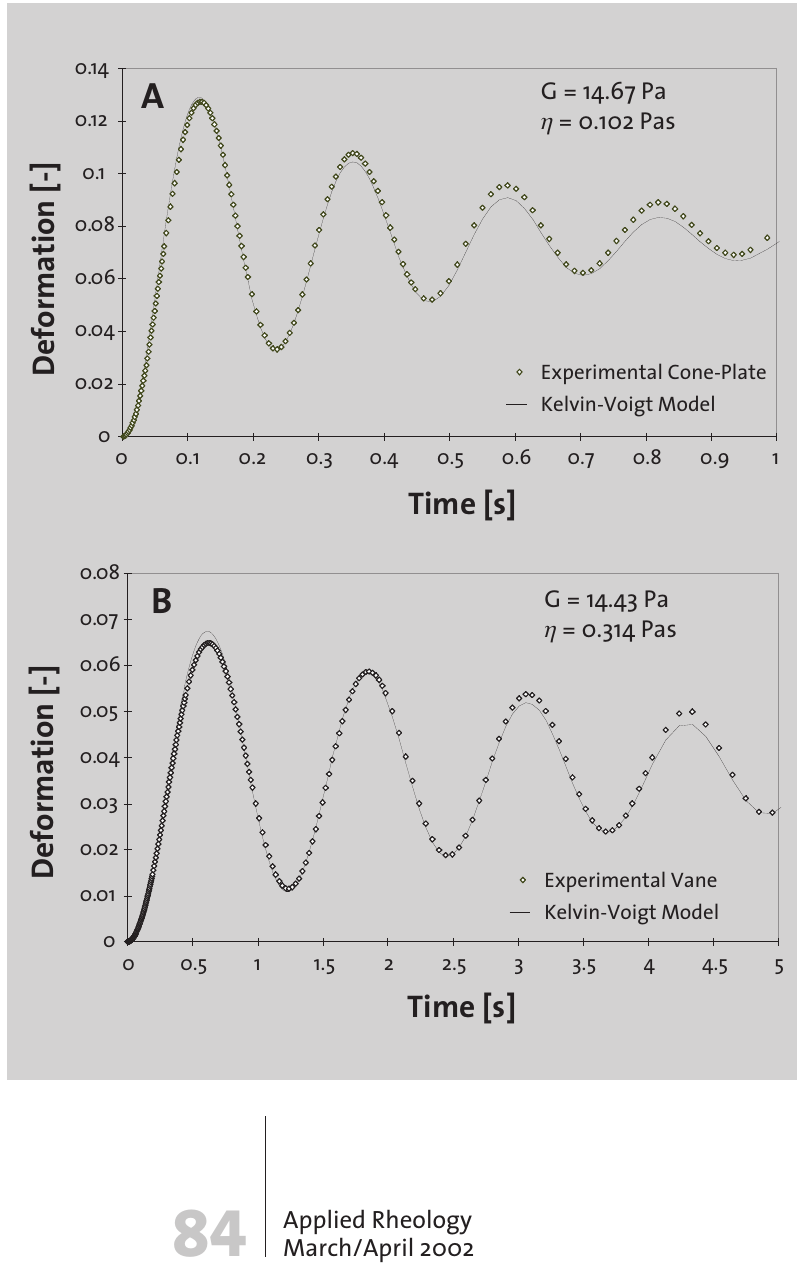
through the hexagonal shape). G and h are, respectively, the elastic modulus and the viscos- ity in the Kelvin-Voigt model. They were the only open parameters in the least squares fit of the experimental data to Eq. 4. Fig. 3 shows the good fit of the model to each set of data. There is excellent agreement between the elastic moduli obtained with the two geome- tries. The difference between the viscosities is Figure 3: probably related to the different frequencies of Creep measurements on a free oscillation, due to the different inertias and 20 g/kg gelatin gel in cone and plate (A) and vane (B) geometric factors ( a = 0.459 for the vane and 0.02 rheometry. Viscoelastic for the cone and plate geometry) and also to the behaviour modelled using different ranges of deformation. the Kelvin-Voigt